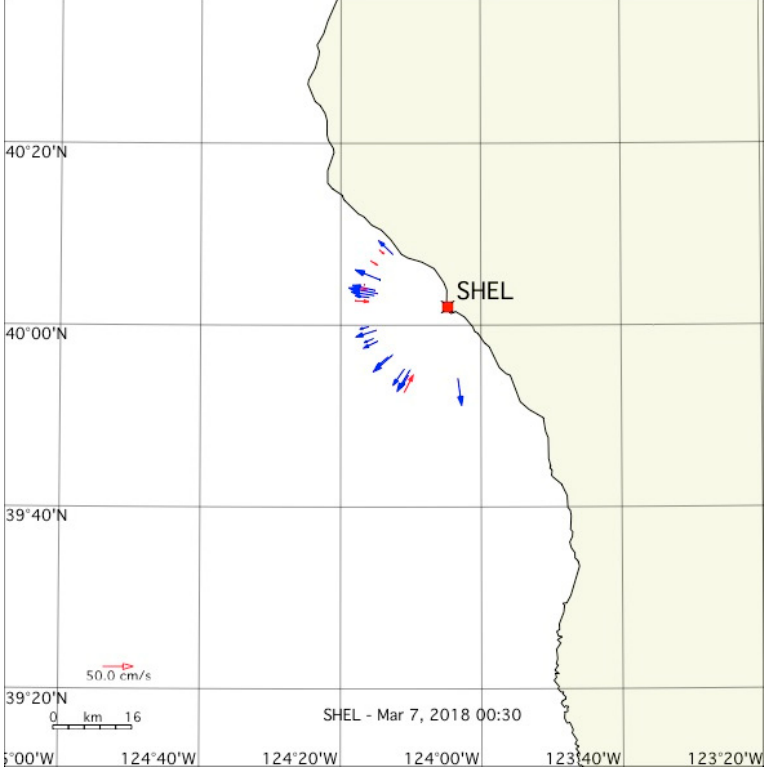
Figure 5. Radial velocities for which the RMS deviations do not exceed 5, from the radar data 7 March, 2018, 00:30 a.m., range 18 km. 2018, 00:30 a.m., range 18